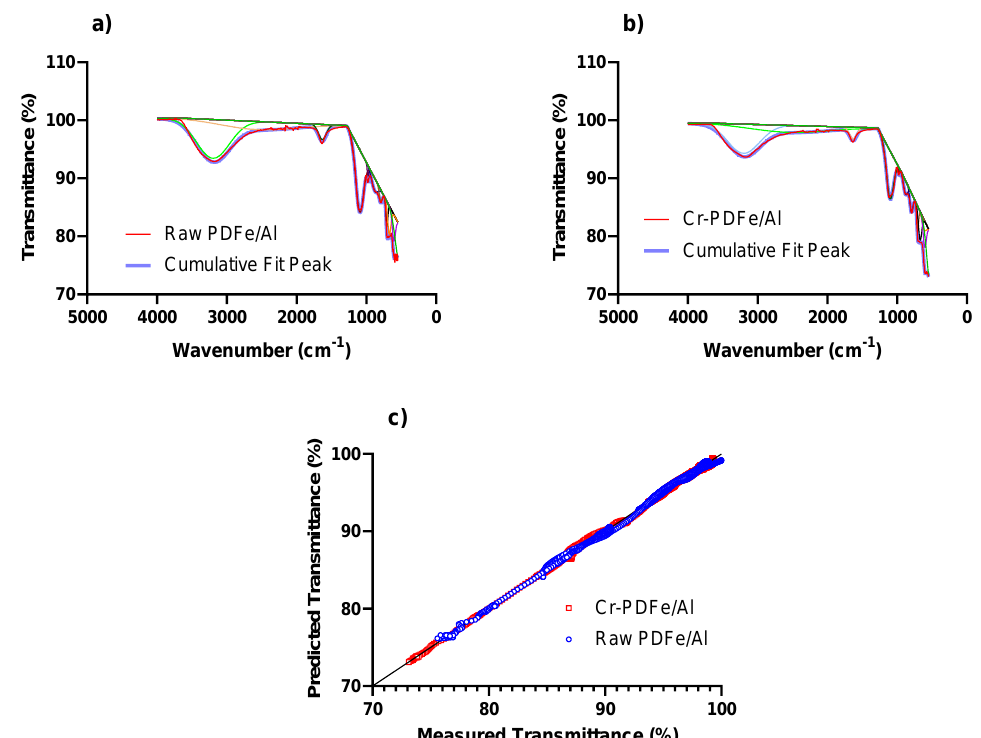
Figure 1. The deconvoluted peaks of the FTIR spectra for PDFe/Al ( a ) before and ( b ) after Cr(VI) adsorption. ( c ) shows the Transmittance for Raw PDFe/Al and Cr-PDFe/Al. Table 2. A summary of peak positions for raw PDFe/Al and Cr-PDFe/Al. Raw PDFe/Al